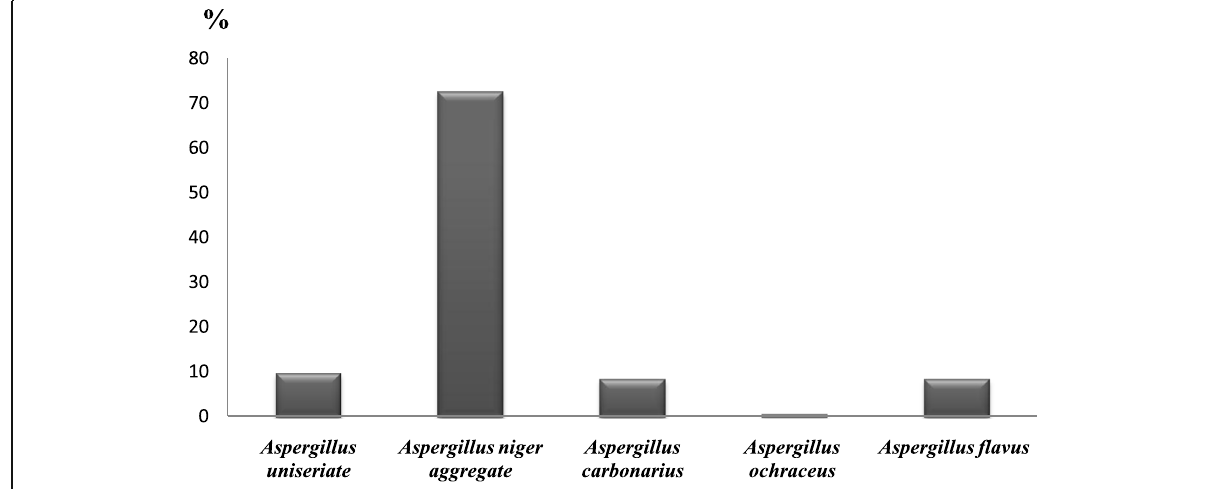
Fig. 1. Occurrence of Aspergillus species isolated from dried grapes samples marketed in Tunisia (n=90)